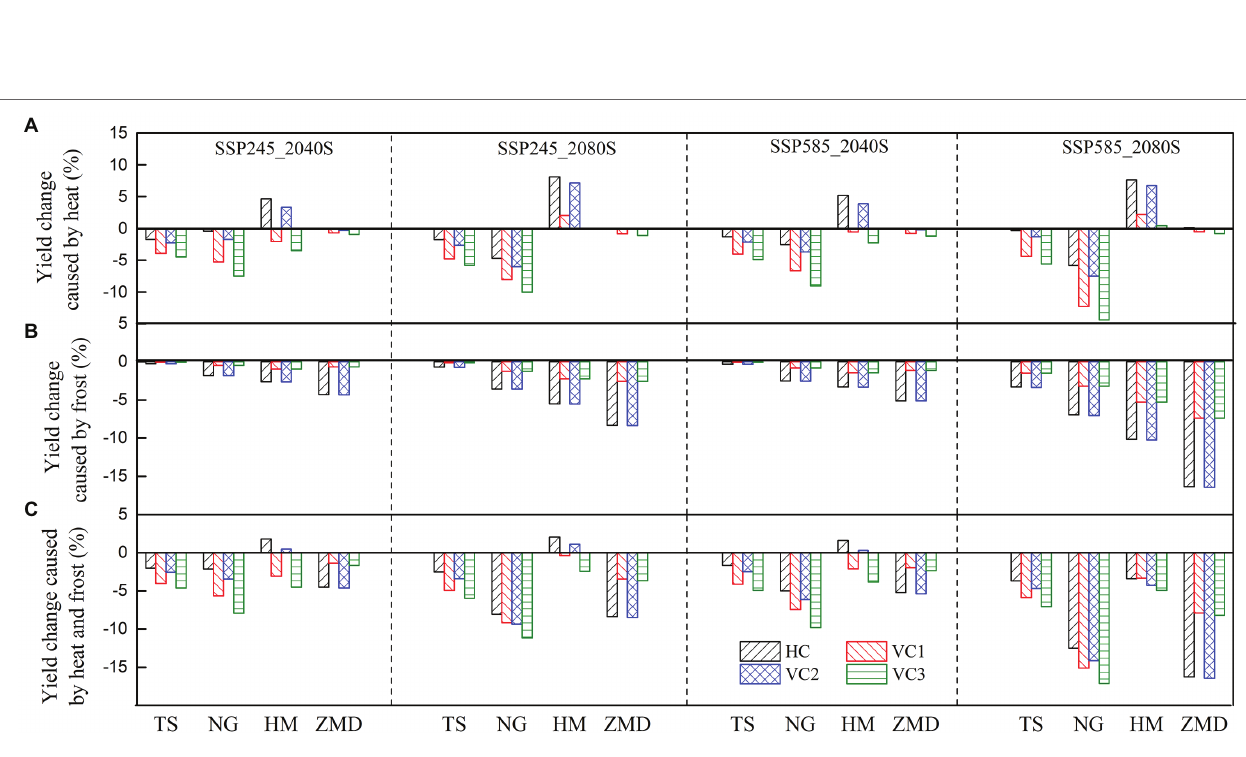
FIGURE 7 | The relative change of impact of heat (A) , frost (B) , heat and frost stress (C) for different cultivars on wheat yield in the 2040S and 2080S under SSP245 and SSP585 scenarios relative to historical cultivar in the baseline